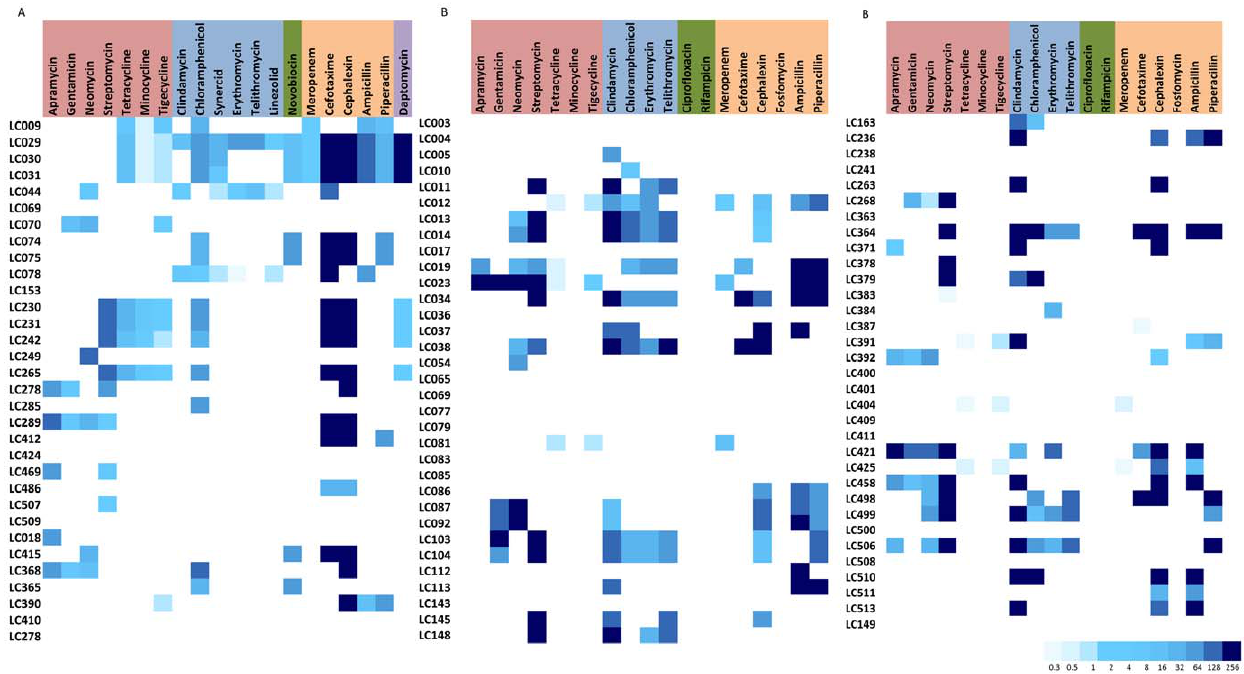
Figure 3. MIC of antibiotics determined in this study. Heat Plot for (A) Gram-positive strains (B) Gram-negative strains against various antibiotics. Antibiotics are grouped according to their mode of action and the gradient from light blue to dark blue represents the range from lowest MIC value (0.3 m g/ml) to highest MIC value (256 m g/ml) as shown in the legend. White means no MIC was determined.